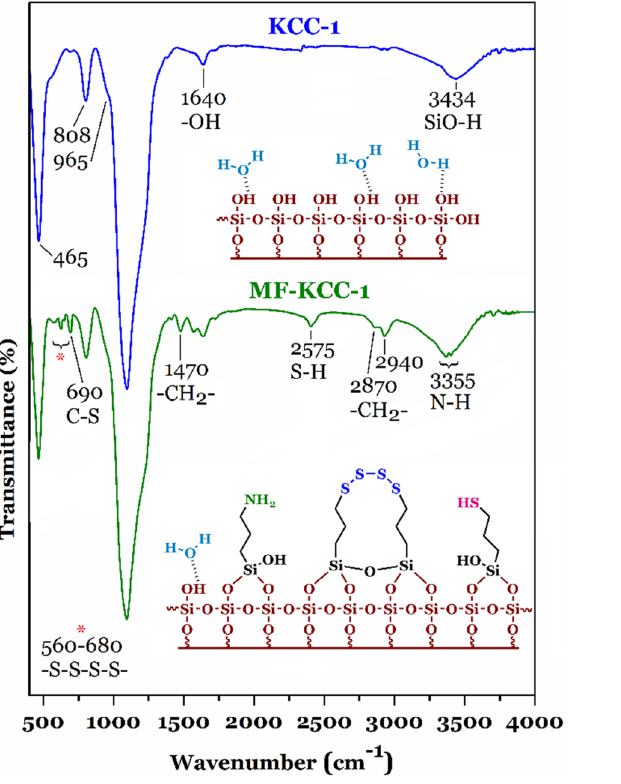
Figure 2. FTIR spectra of the